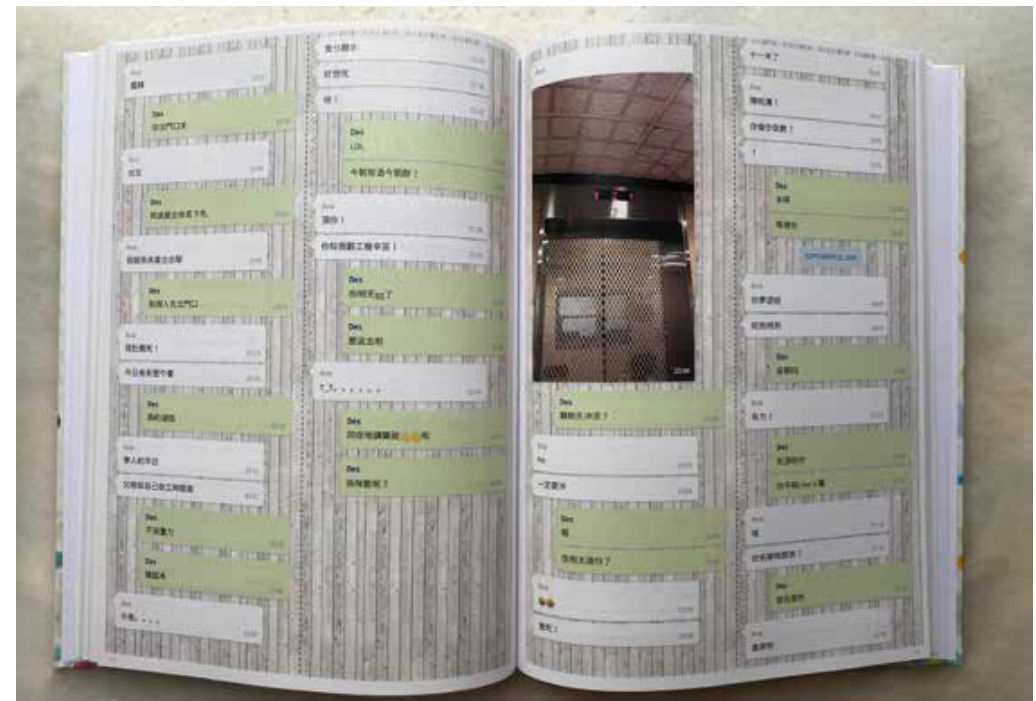
Figure 8: Desmond Chan’s artwork, inspired by Ha’s letter writing practice. Source: Chow